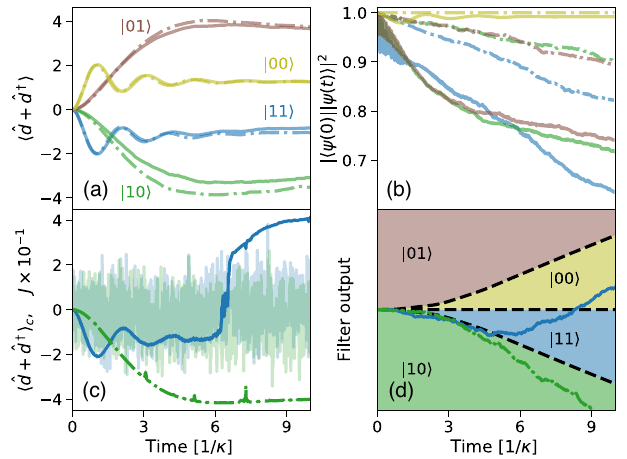
FIG. 1. (a) Ensemble-averaged cavity field quadrature during readout, for each initial qubit state j ψ ð 0 Þi ¼ j z i . (b) Ensemble- averaged decay of the initial qubit state occupation during measurement: jh ψ ð 0 Þj ψ ð t Þij 2 . In all plots, results for the dis- persive and JC models are shown in dash-dotted and solid lines, respectively, and j ψ ð 0 Þi for each curve is indicated via the colors labeled in (a). Panels (c) and (d) demonstrate the matched filtering of dispersive measurement currents. In (c) we show sample ˆ H readout cavity quadratures for initialized in j 11 i (blue) and JC ˆ H in j 10 i (green). The corresponding measurement currents J D are also plotted, reduced by an order of magnitude for visibility. The subsequent filtered readout signals y ð t Þ are shown in (d), as computed via an ideal Q → ∞ matched filter. The filtered output is classified according to which expected bin it falls in, which are labeled with their associated quantum state. All figures are for the parameters in